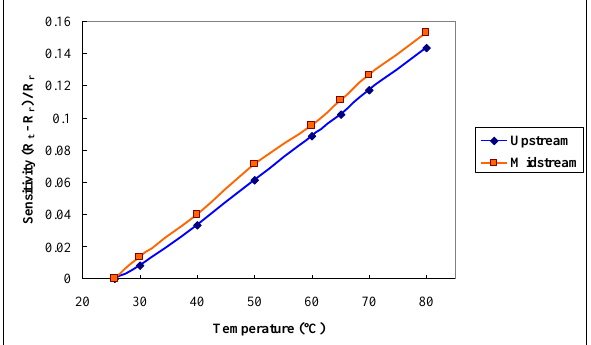
Figure 5. Calibration curves of micro temperature sensors in upstream and midstream.